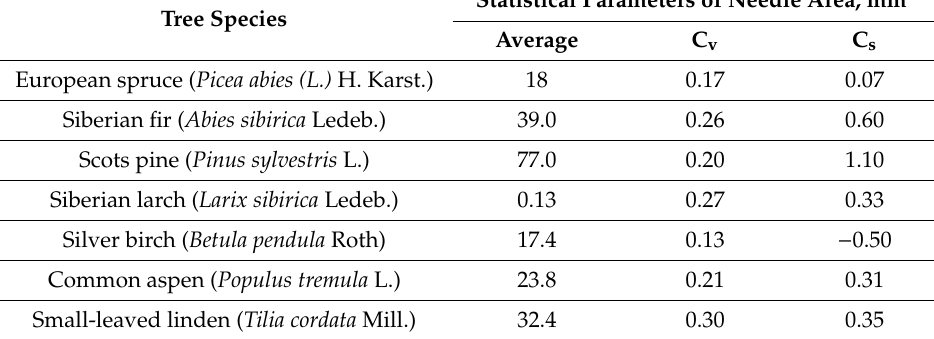
Table 2. Statistical parameters of leaf (conifer needle) size of individual tree species (Site-quality class II, age 60–100 years). Statistical Parameters of Needle Area, mm 2 Tree Species Average C v C s European spruce ( Picea abies (L.) H. Karst.) Siberian fir ( Abies sibirica